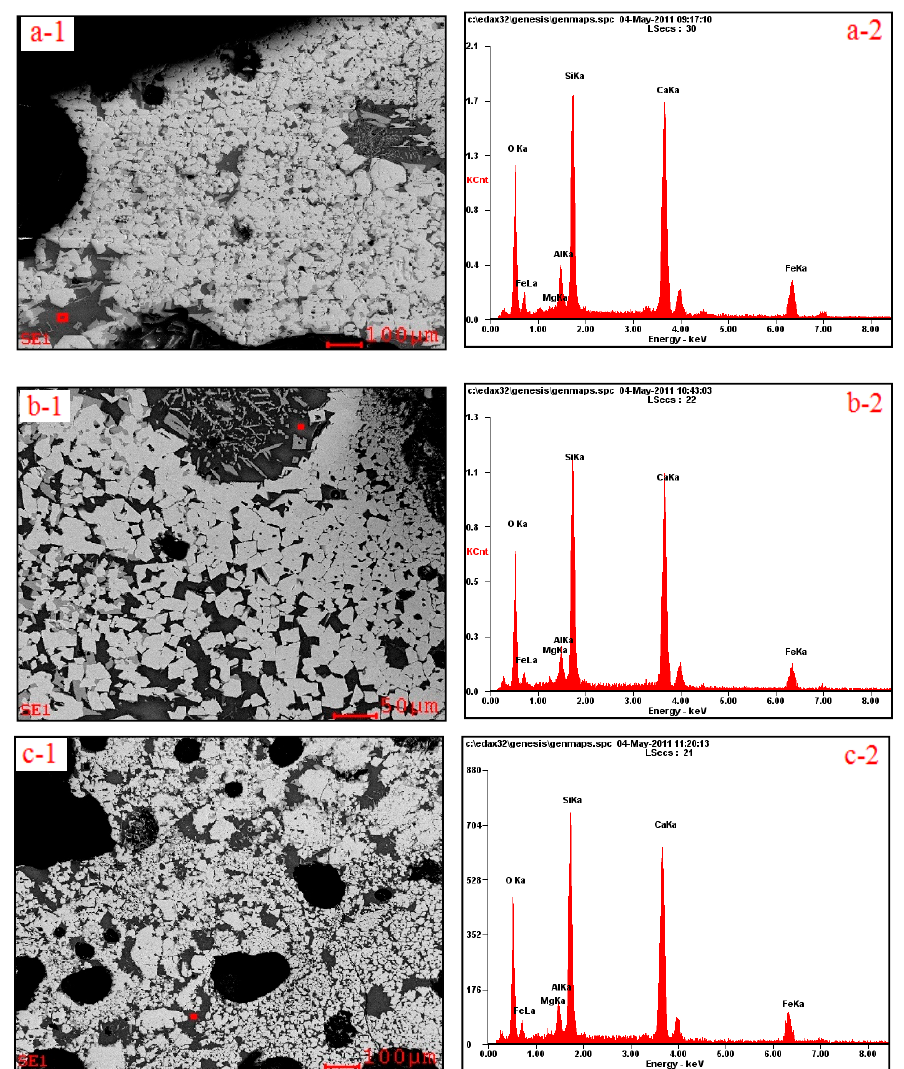
Figure 8. Effects of SiO 2 content on mineral composition.